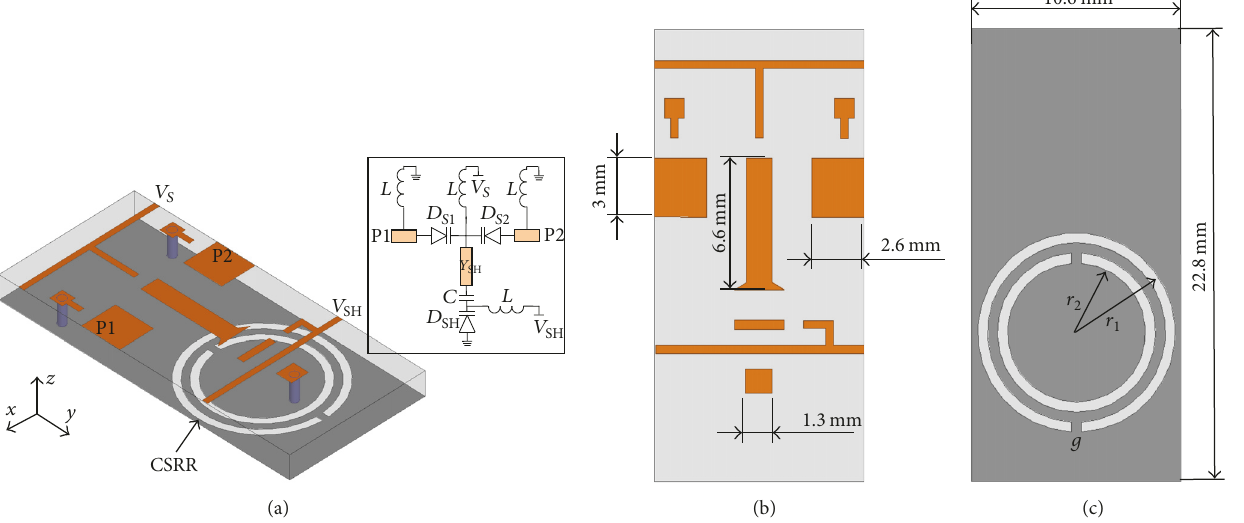
Figure 2: (a) 3D HFSS model of the LWA unit cell, with CSRR etched on the ground plane. (b) 2D top layer layout and dimensions. (c) Bottom layer with ground plane and CSRR design. 𝑟 1 = 5 mm and 𝑟 2 = 4 mm. The gap 𝑔 and the distance between the two rings are 0.5